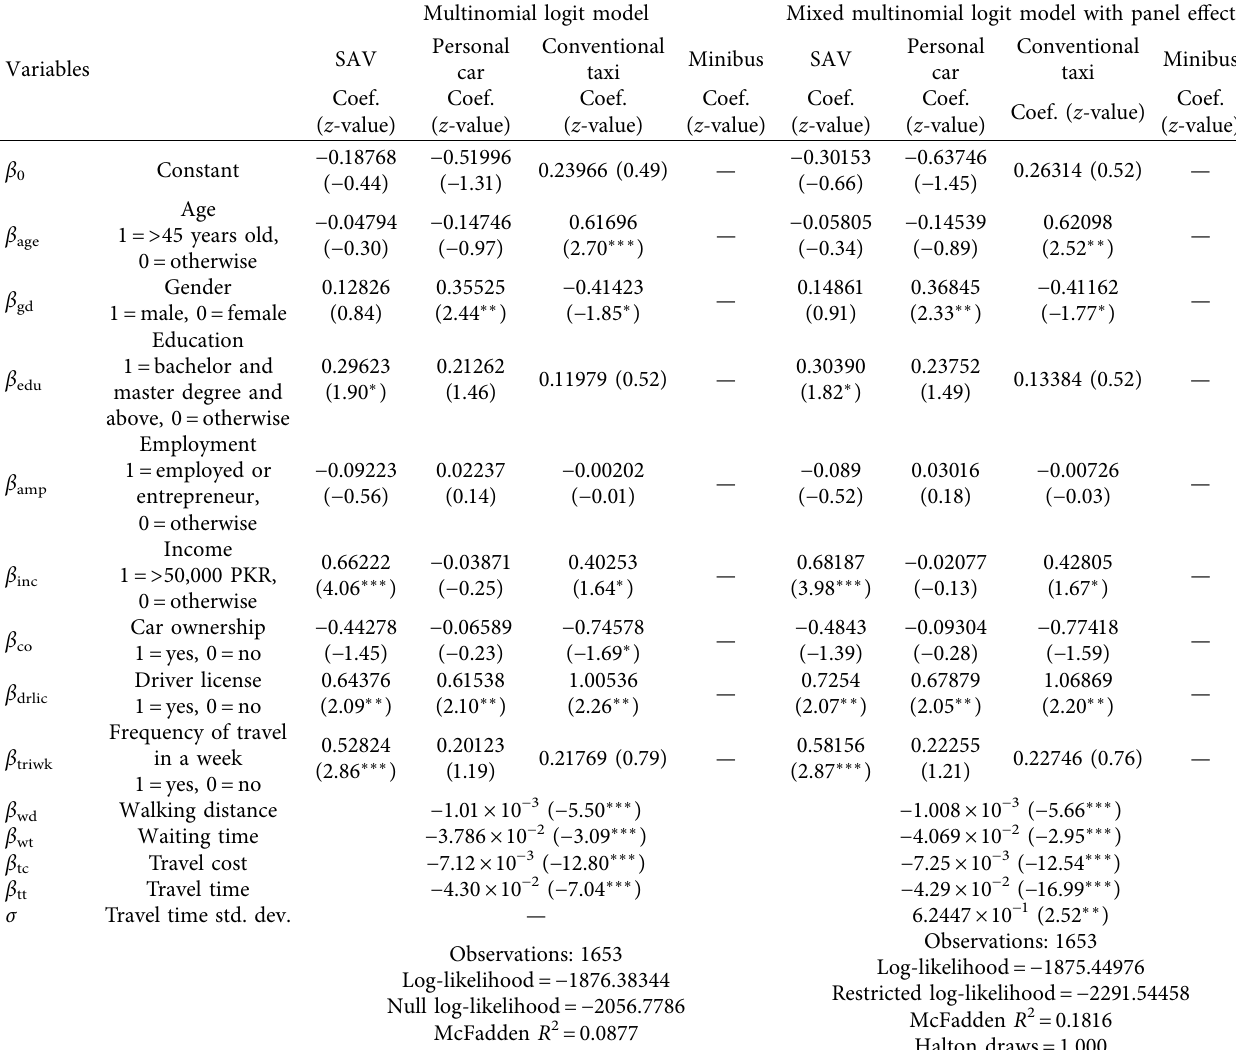
Table 6: Model estimates for Lahore,